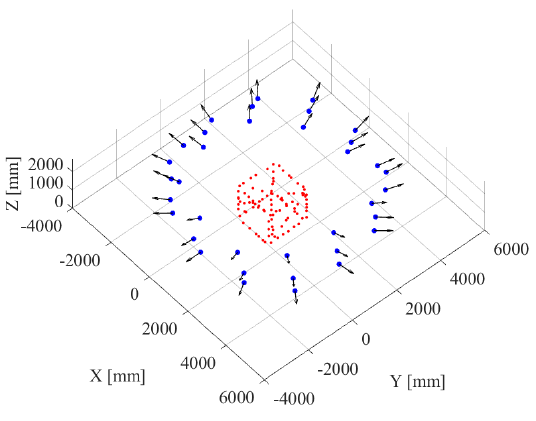
Figure 4. Exterior Orientations of 1 SM -1/99 (blue dots). The vectors indicate the systematic difference between the exterior orientations of 1 SM -1/99 and 1 MM -1/99 of about 6.5mm in average.